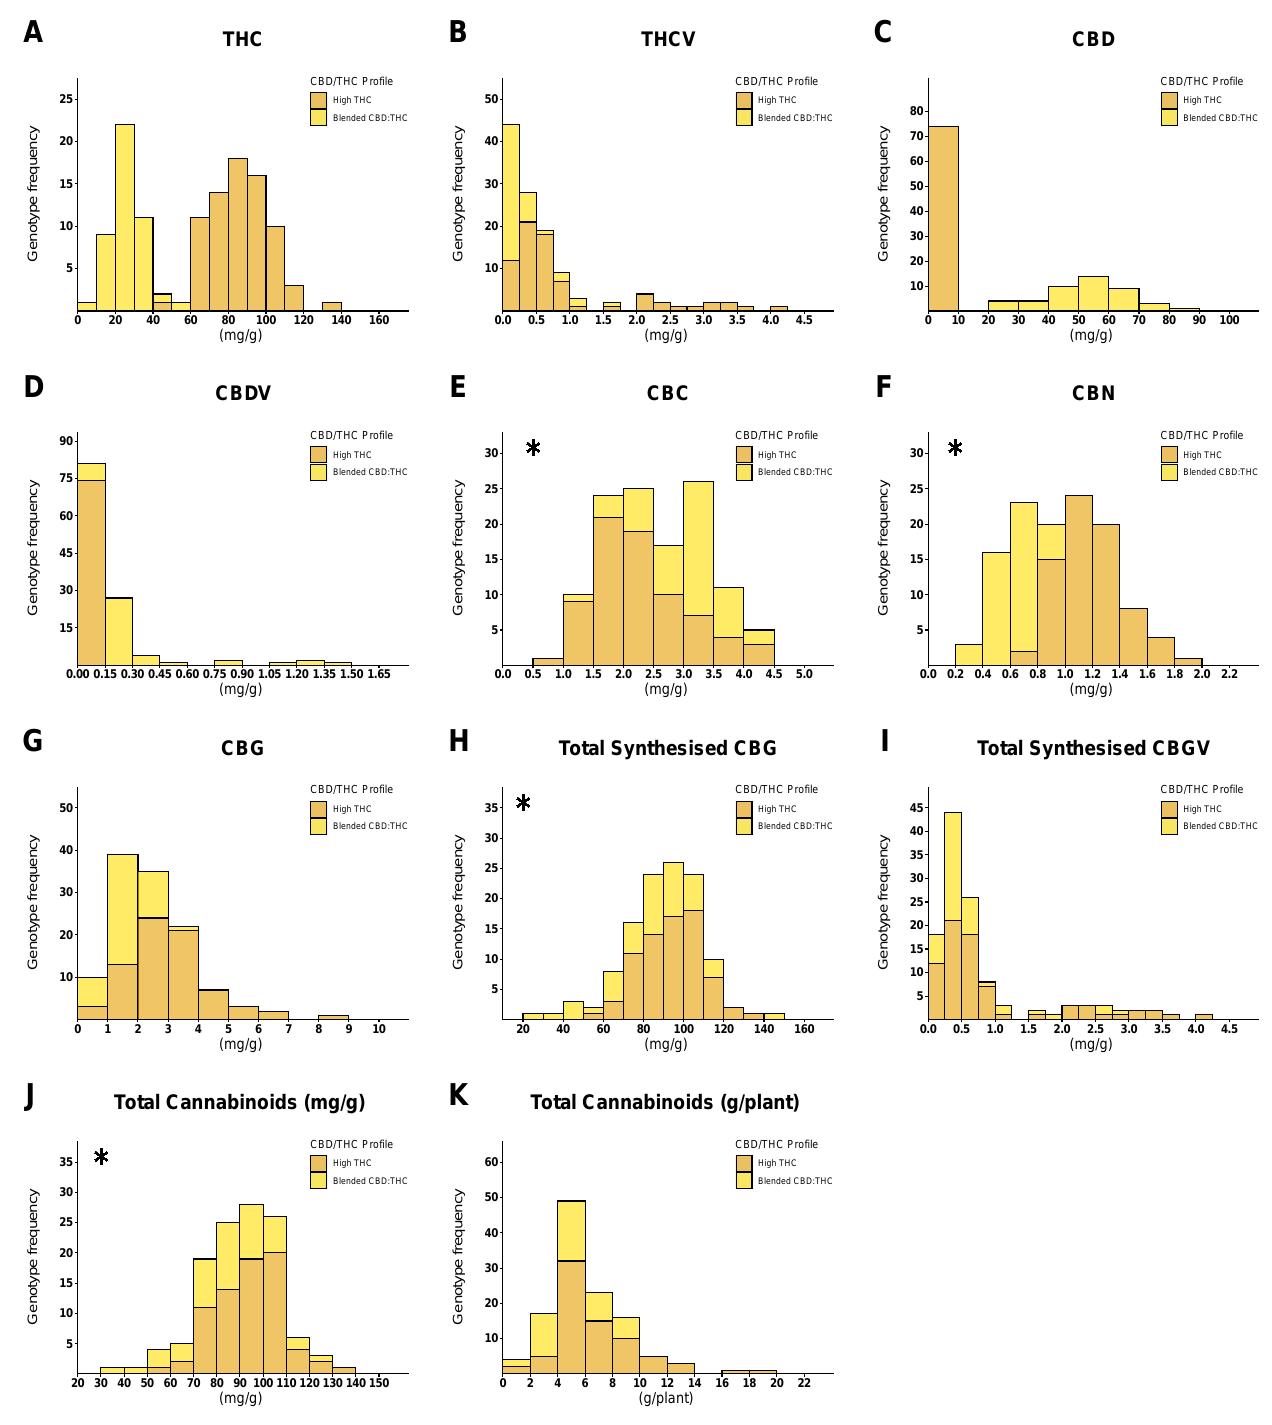
Figure 1. Frequency distribution of 119 cannabis genotypes across 11 cannabinoid parameters. Or- ange segments represent high-THC genotypes, and yellow segments represent blended THC:CBD genotypes. Charts marked with an asterisk on the top left corner are normally distributed. ( A ) ∆ 9 -tetrahydrocannabinol (THC) content (mg/g), ( B ) ∆ 9 -tetrahydrocannabivarin (THCV) con- tent (mg/g), ( C ) cannabidiol (CBD) content (mg/g), ( D ) cannabidivarin (CBDV) content (mg/g), ( E ) cannabichromene (CBC) content (mg/g), ( F ) cannabinol (CBN) content (mg/g), ( G ) cannabigerol (CBG) content (mg/g), ( H ) total synthesised CBG (mg/g), ( I ) total synthesised CBGV (mg/g), ( J ) total cannabinoid concentration (mg/g), ( K ) total cannabinoid per plant